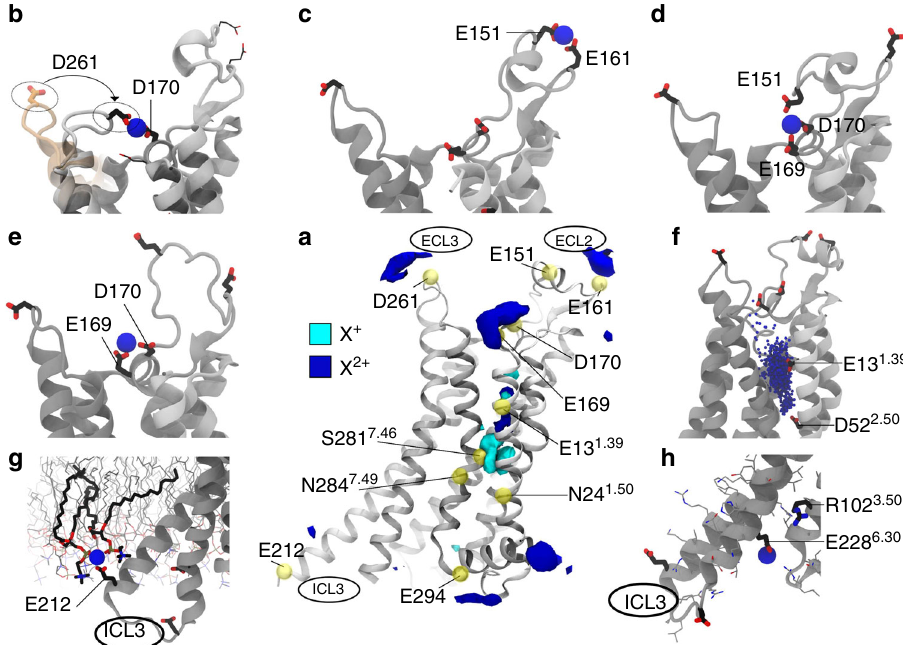
Fig. 5 Atomistic MD simulations of divalent cation binding by A 2A R. a Spatial distribution of cations around A 2A R. Surfaces enclose cation density 3 k B T above homogeneous populations for monovalent (cyan) and divalent (blue) cations in simulations of three agonist-bound A 2A R crystal structures [PDB IDs: 2YDO, 3QAK and 5G53]. b – e Divalent cation bridges observed in the receptor ’ s extracellular domain. Orange ECL3 in part ( b ) shows the initial conformation and highlights the reorganization of D261 during MD simulation. f Divalent cation binding close to the sodium pocket, coordinated by acidic residues E13 1.39 or D52 2.50 . g Divalent cation bridging between E212 and a phosphoryl group in the lipid bilayer. h Divalent cation binding to E228 6.30 (ionic lock: DR102 3.50 Y — E228 6.30 ) (see also Fig. 7)